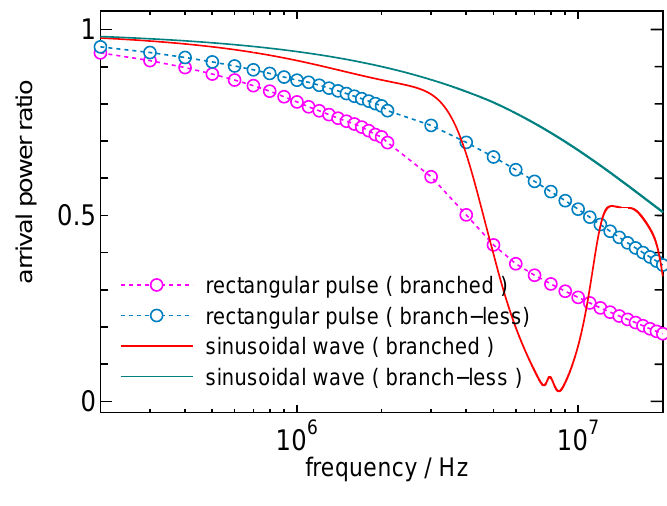
Figure 8. Arrival power ratio for rectangular pulse and sine wave.